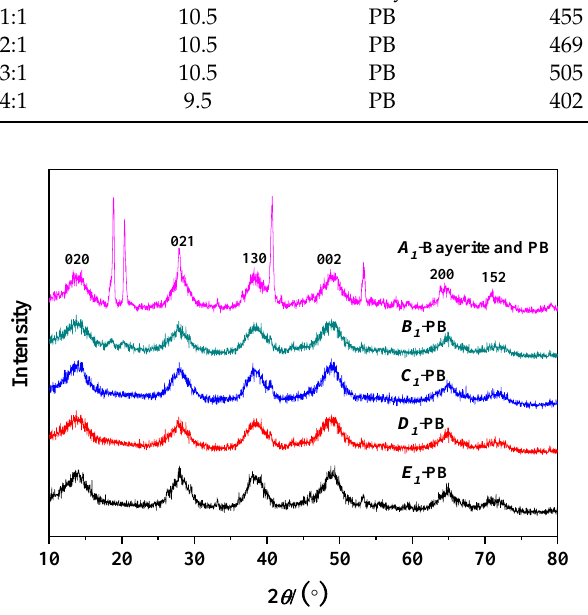
Figure 5. XRD results of PB with different gas – liquid ratios on pore properties (concentration of NaAlO 2 solution, 0.1 mol/L; rotating speed of CF-RPB, 600 rpm).